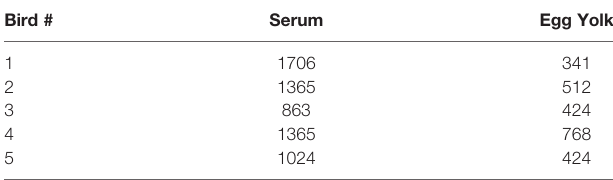
TABLE 1 | In Vitro Virus Neutralization